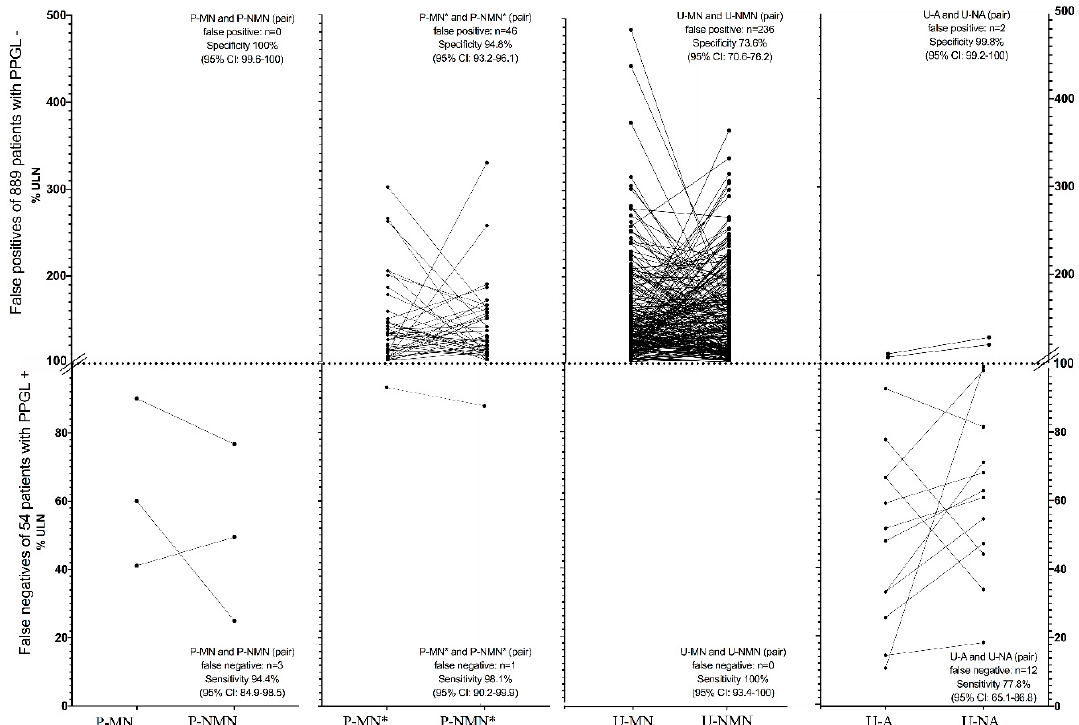
Figure 3. False negative results of 54 patients with PPGL + (below dotted line depicting the ULN) and false positive results of 889 patients with PPGL- (above dotted line) of the combined parameters (P-MN + P-NMN, U-MN + UNMN, U-A + U-NA). Intraindividual measurements within the pairs of parameters are connected with solid lines. The asterisks (*) denote P-MN and P-NMN with the corrected ULN as proposed by others [17]. Please note the different scale below and above the dotted line.